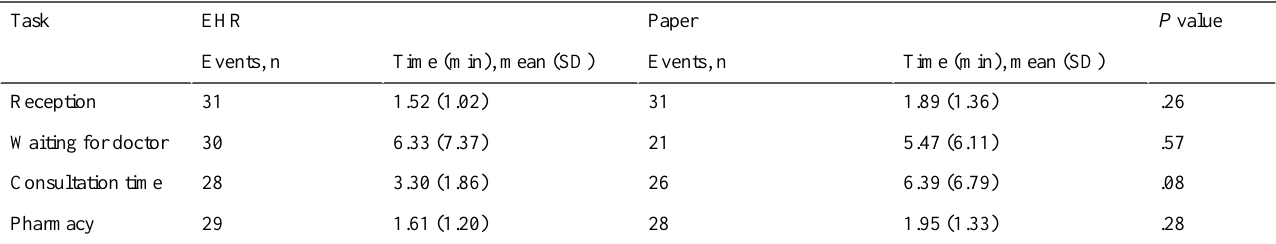
Table 1. The time per task for primary health care centers using the electronic health record (EHR)–based system versus the paper-based system.